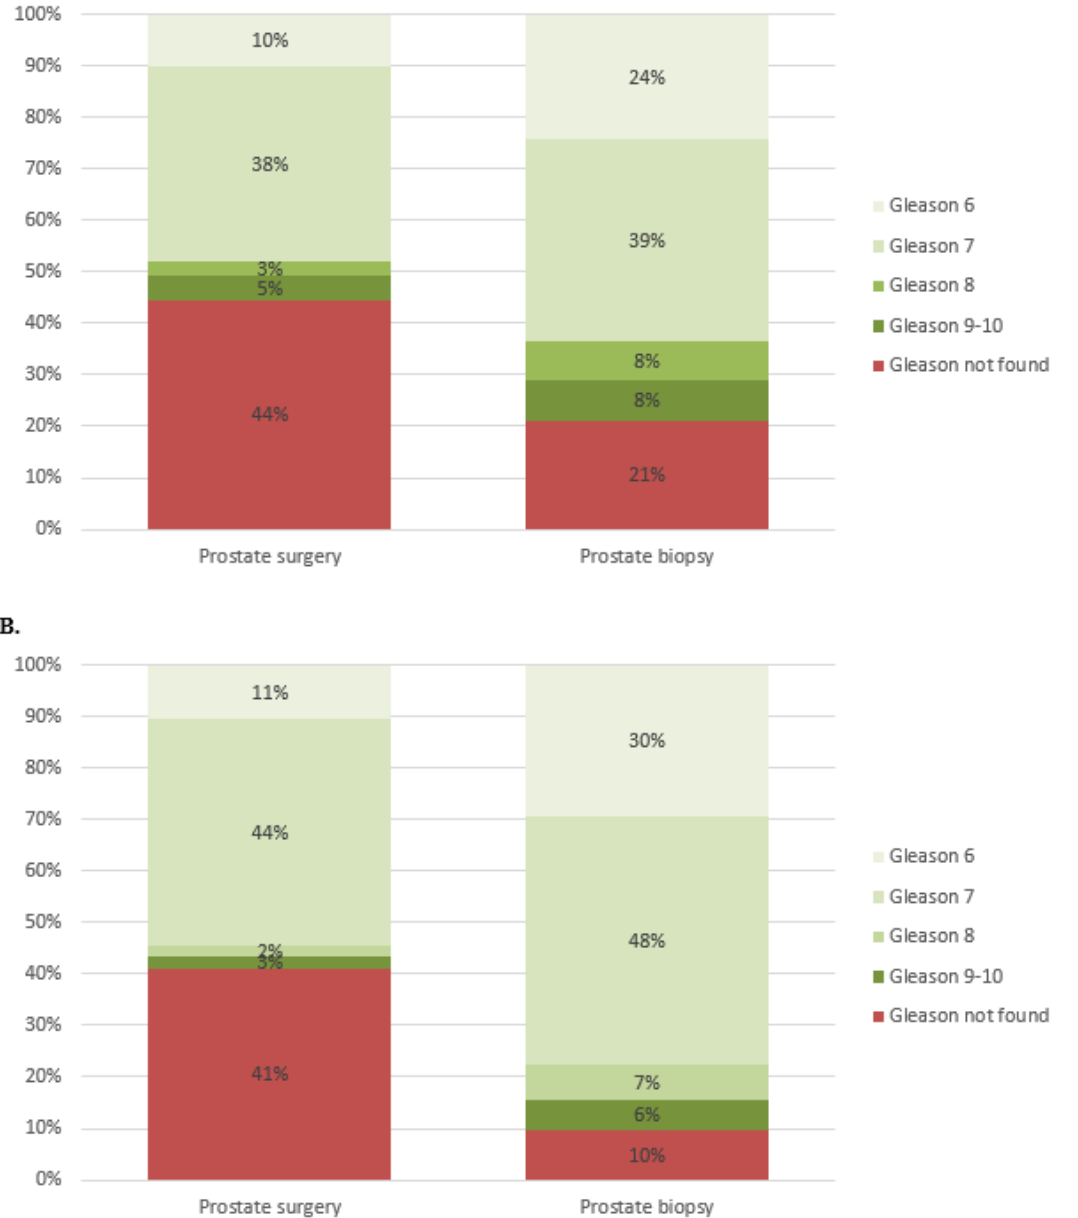
Figure 3. Distribution of NLP Gleason score extractor results for (A) the full cohort and (B) the randomly selected 200 patients. NLP: natural language